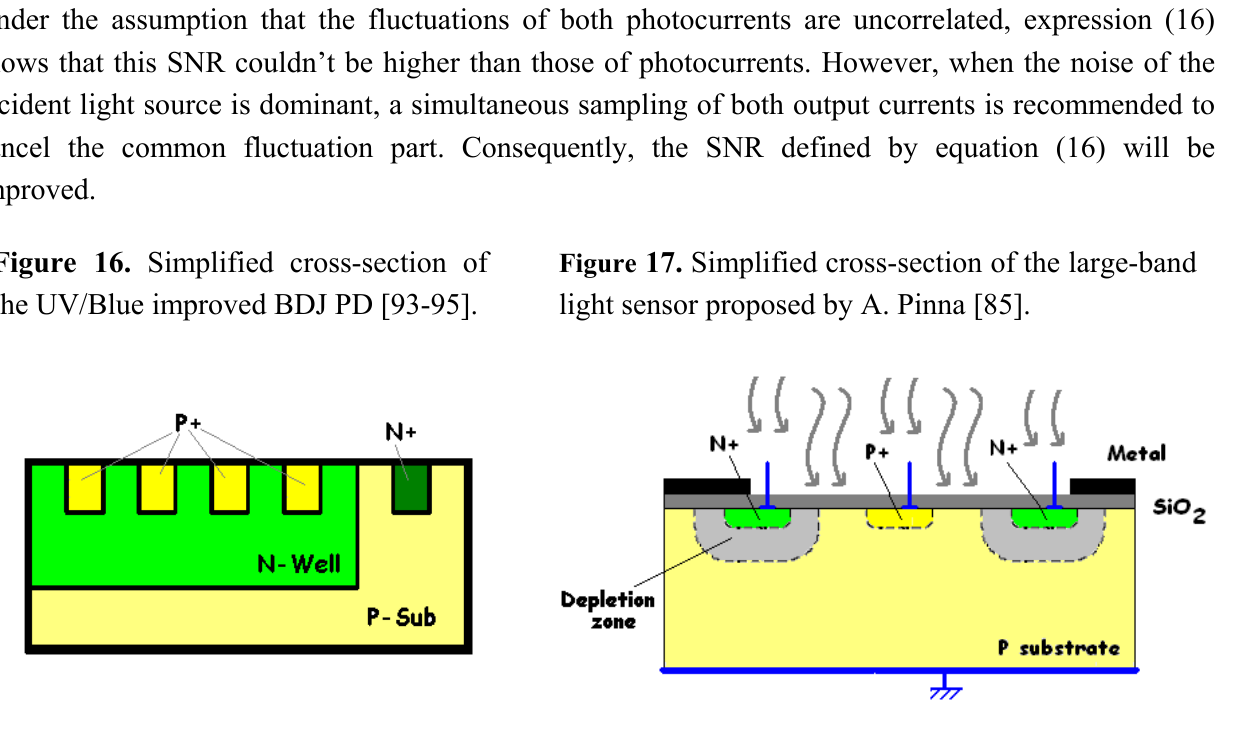
Figure 18. Associating the BDJ PD with a two-dimensional (2-D) metal grid